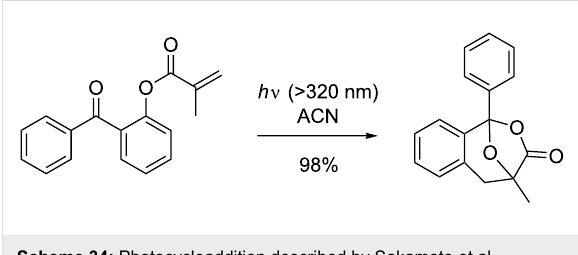
Scheme 32: Photocycloaddition of enone with